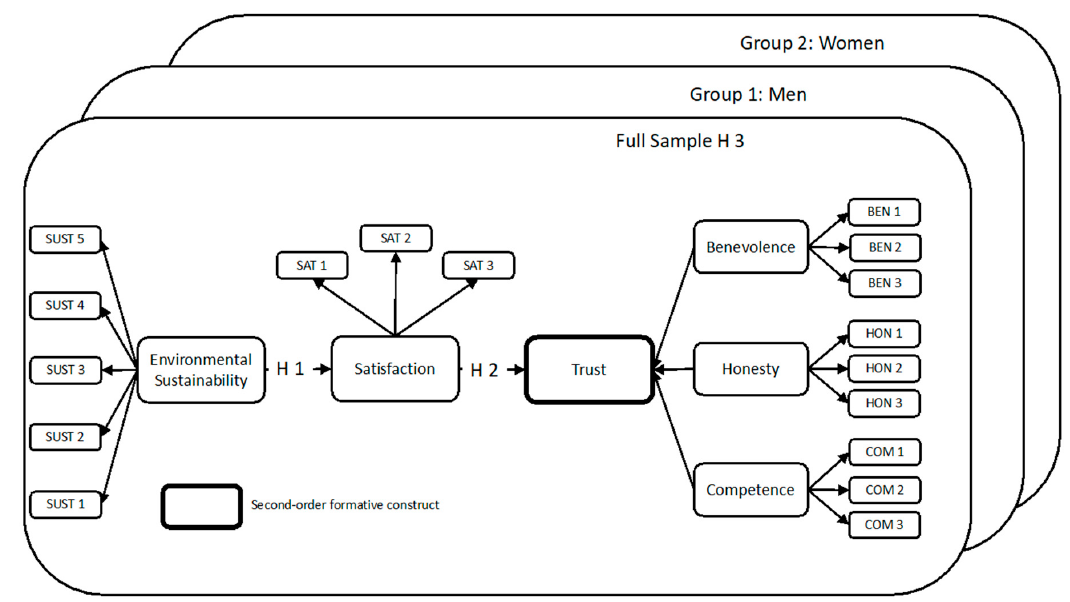
Figure 1. Research model used in the present study.